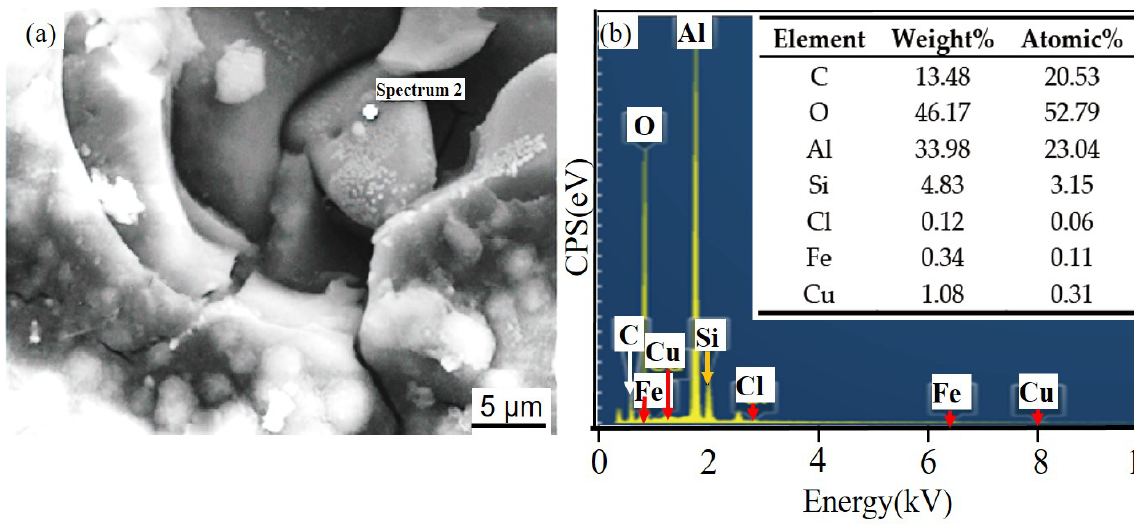
Figure 14. EDS of particle in the corrosion pits of SiC 3D /6061Al after SL for 21 days. ( a ) SEM image of particles in the corrosion pit; ( b ) EDS of particle.